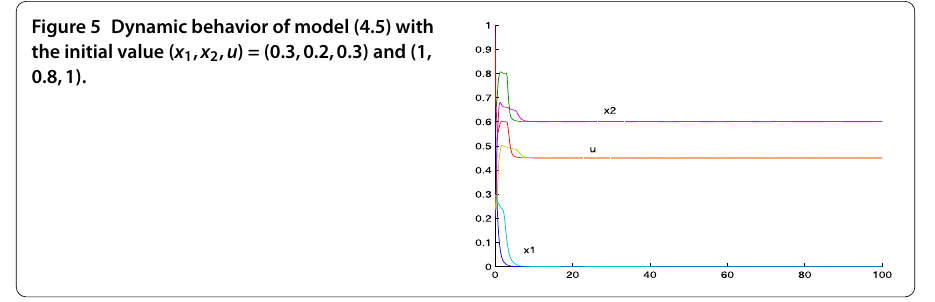
Figure 5 Dynamic behavior of model (4.5) with the initial value ( x 1 , x 2 , u ) = (0.3,0.2,0.3) and (1,